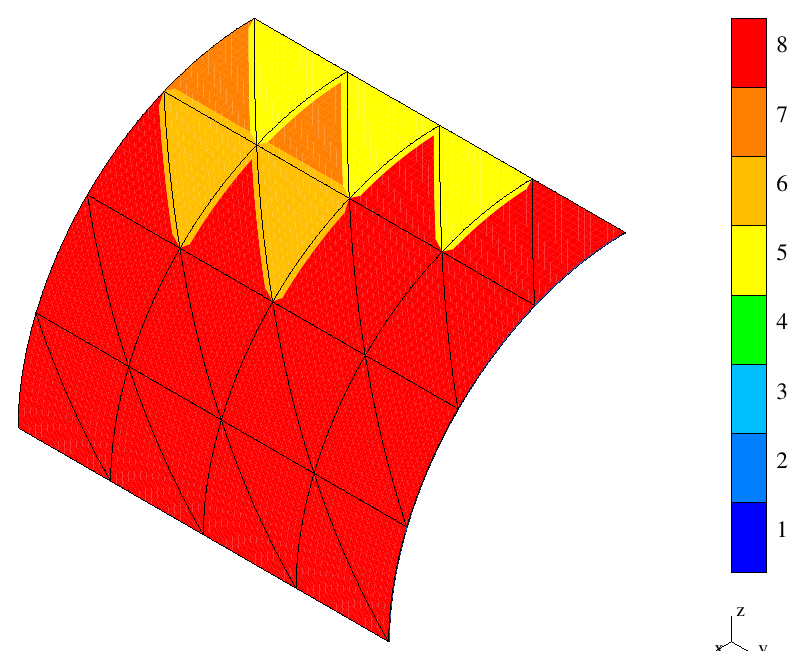
Figure 25. A quarter of a bending-dominated shell—after optimization and hp -adaptation.